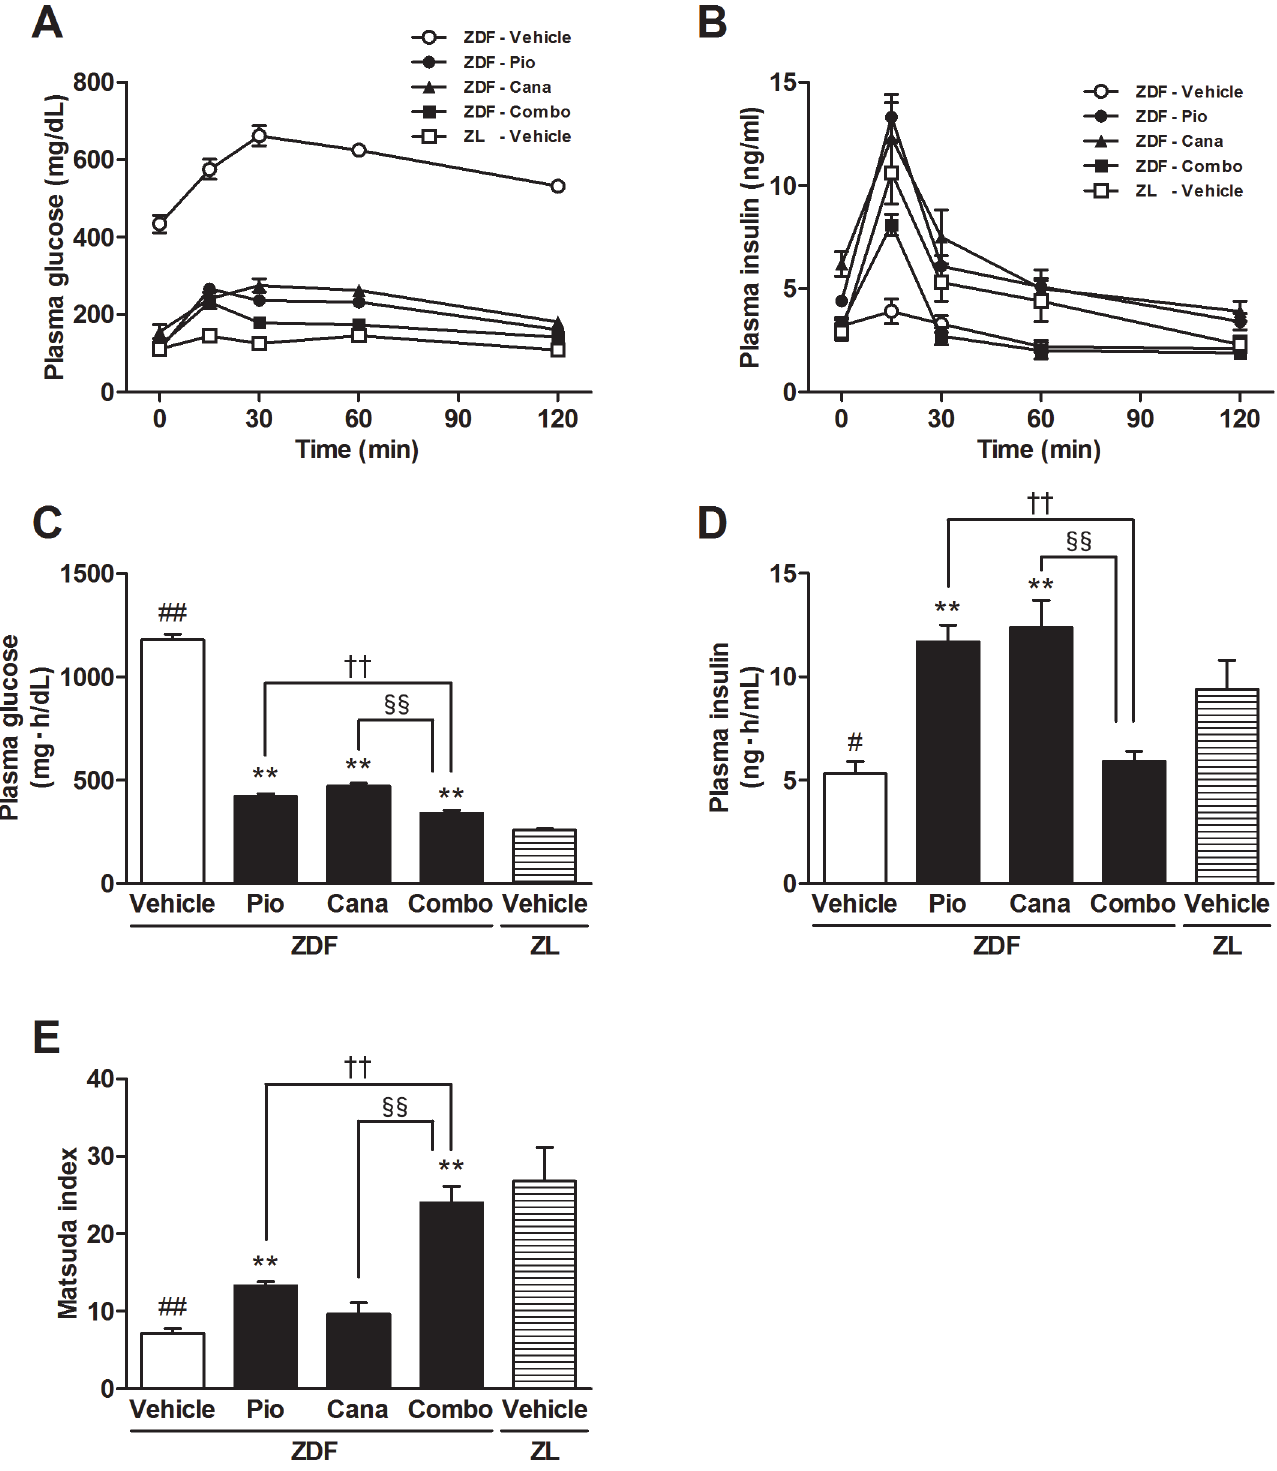
Figure 6. The oral glucose tolerance test (OGTT) and Matsuda index in ZDF and ZL rats. A: Plasma glucose, B: Plasma insulin, C: AUC 0 – 2 h of plasma glucose, D: AUC 0 – 2 h of plasma insulin, and E: Matsuda index. Canagliflozin (Cana; daily dose of 10 mg/kg), pioglitazone (Pio; daily dose of 10 mg/kg), and their combination (Combo) were administered by oral gavage for 6 weeks. OGTT was performed 2 days after the last dosing. Data are expressed as mean ± SEM (n = 8). # P < 0.05, ## P < 0.01 vs. ZL rats, * P < 0.05, ** P < 0.01 vs. vehicle-treated ZDF rats, †† P < 0.01 vs. Pio-treated ZDF rats, §§ P < 0.01 vs. Cana-treated ZDF